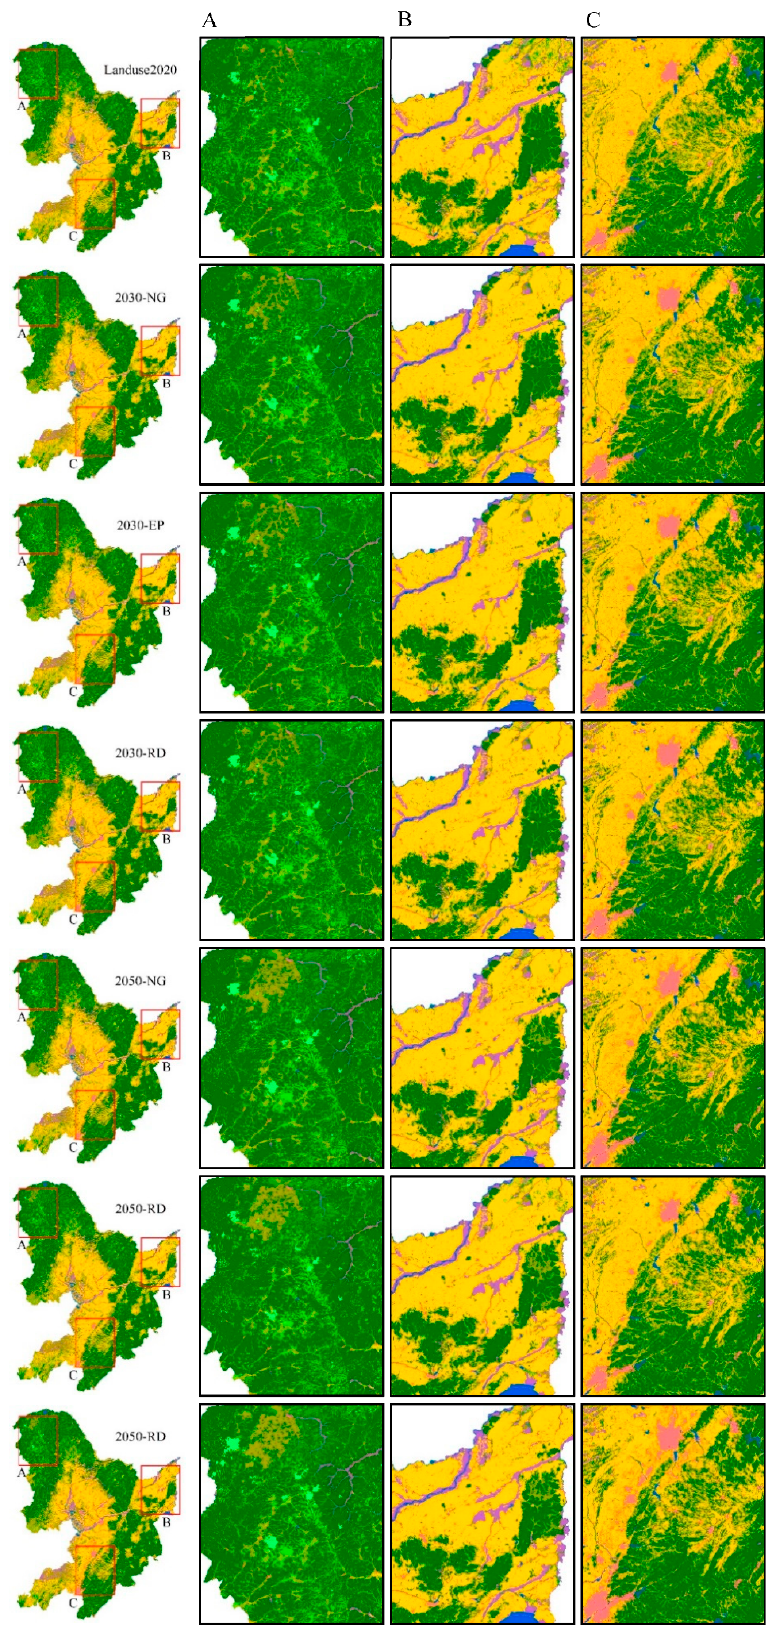
Figure 9. Future land simulations under different scenarios (( A – C ) are three selected areas).